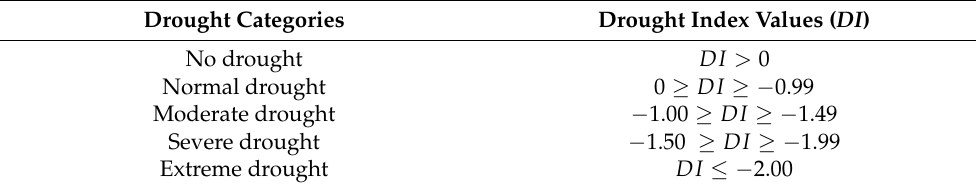
Table 4. Drought categories based on the drought index